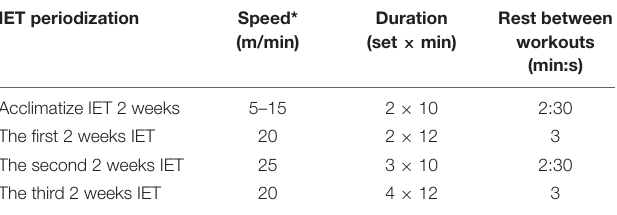
TABLE 1 | Interval exercise training protocol.